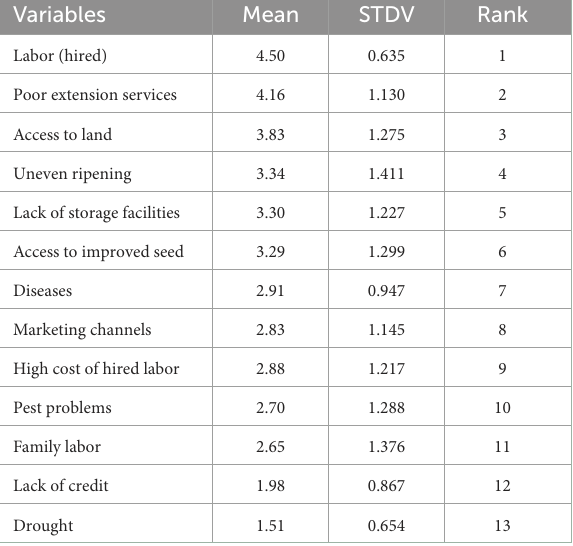
TABLE 7 Challenges faced by sesame farmers in the study area.